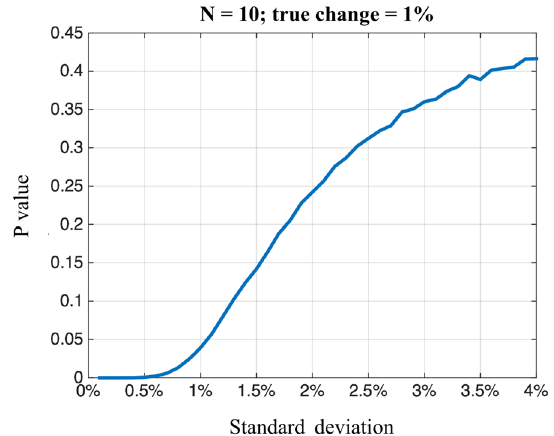
Fig. 7 A simulation illustrating the statistical significance of a small enhancement of BD measurement reliability. When the test‑retest standard deviation is reduced from 1.42% to 1.11%, the p value decreases from 0.13 to < 0.05 (assume N = 10; true change =